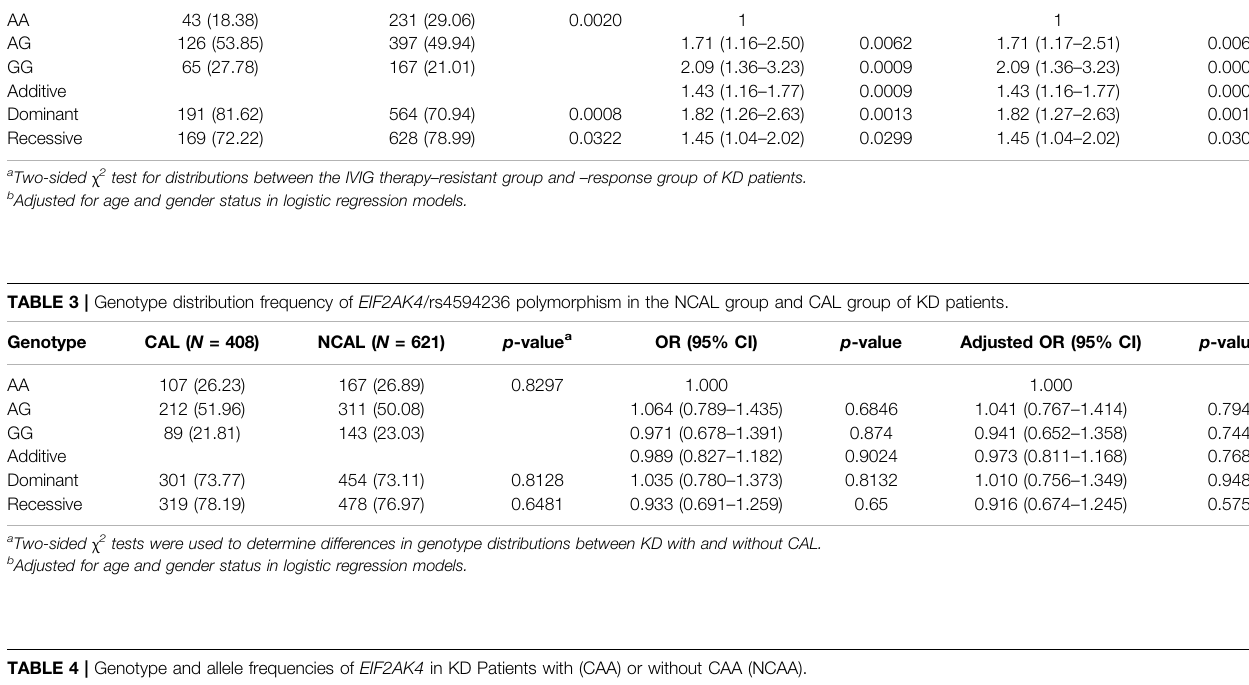
TABLE 4 | Genotype and allele frequencies of EIF2AK4 in KD Patients with (CAA) or without CAA (NCAA).